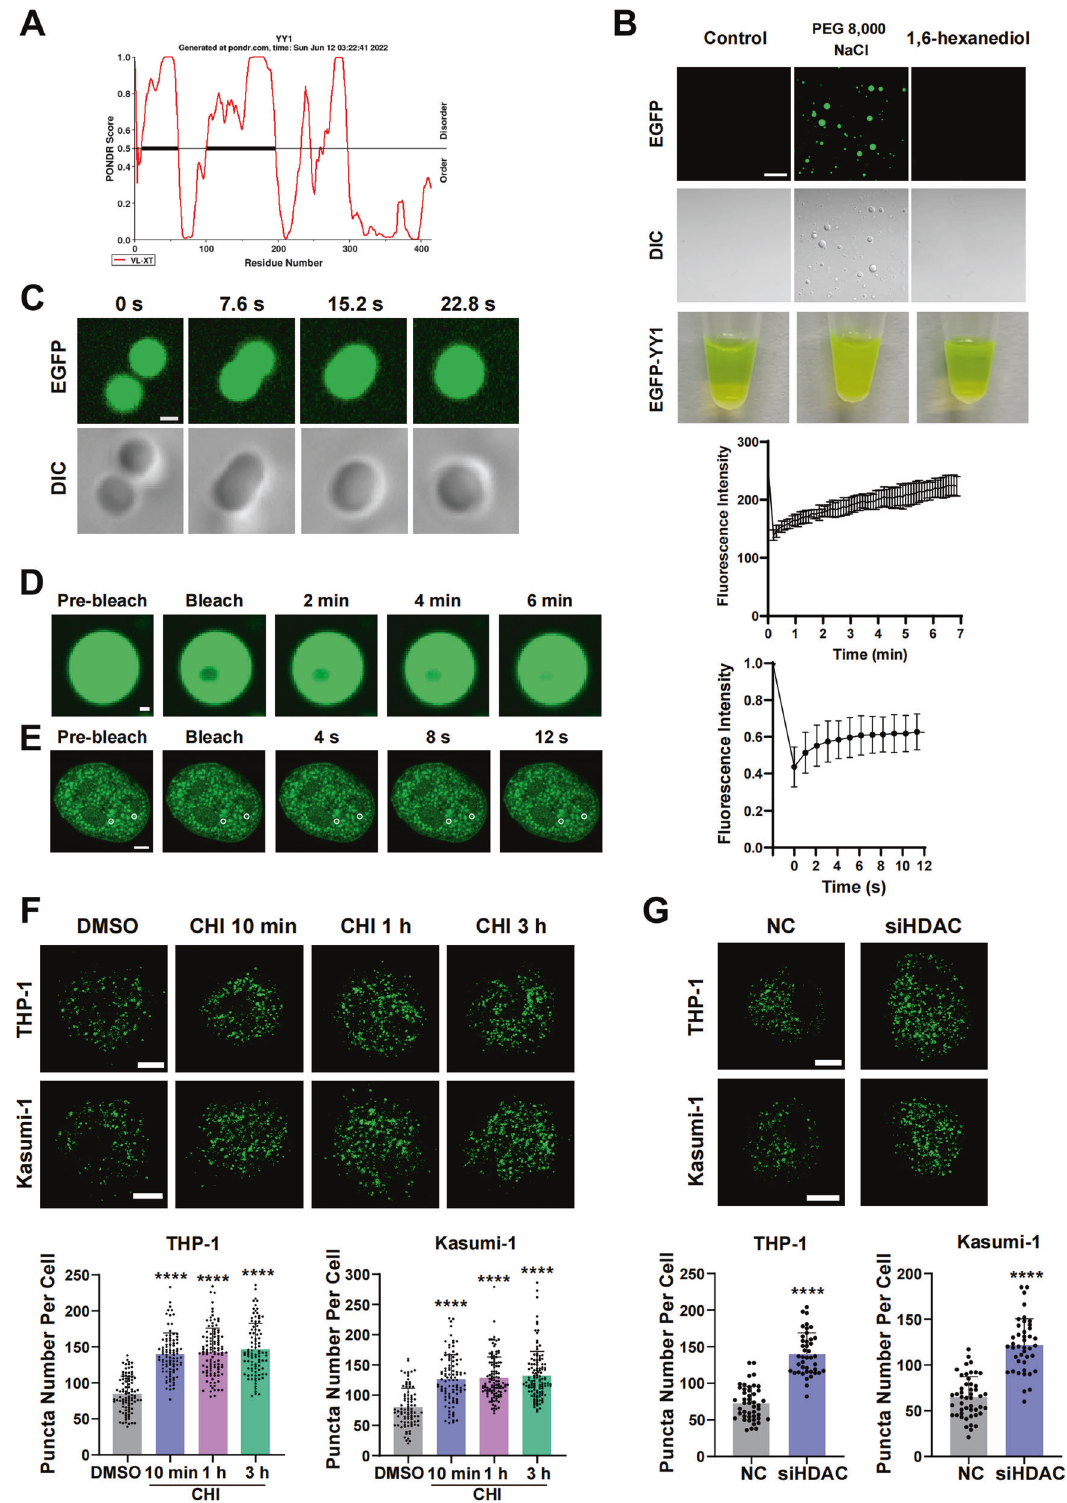
Fig. 5 YY1 undergoes phase separation in an HDAC1/3-dependent model. A Disorder analysis of the YY1 amino acid isoform. The algorithms used were VLXT. The line indicates 0.5 disordered score, above which the amino acid sequence is disordered. B Fluorescence/DIC images and turbidity visualization of EGFP-YY1 droplet formation in a buffer containing 2 μ l 4 M NaCl and 8 μ l 10% PEG-8,000 (the same condition hereafter, if not speci fi ed). Scale bar, 20 μ m. C Droplet fusion shown under fl uorescent (top) and bright- fi eld (bottom) illumination. Scale bar, 1 μ m. D FRAP of YY1-EGFP droplets. FRAP curve is shown at right. Scale bar, 0.5 μ m. E FRAP of YY1 in U2OS cells. FRAP curve is shown at right. Scale bar, 5 μ m. F THP-1 and Kasumi-1 cells treated with 4 μ M CHI, endogenous YY1 immuno fl uorescence (top), and number of fl uorescent particles (bottom). **** P < 0.0001, t -test. Scale bars, 5 μ m. G THP-1 and Kasumi-1 cells were transfected with si-NC or siHDAC1 and siHDAC3, endogenous YY1 immuno fl uorescence (top), and number of fl uorescent particles (bottom). **** P < 0.0001, t -test. Scale bars, 5 μ m. Cell Death and Disease (2022)